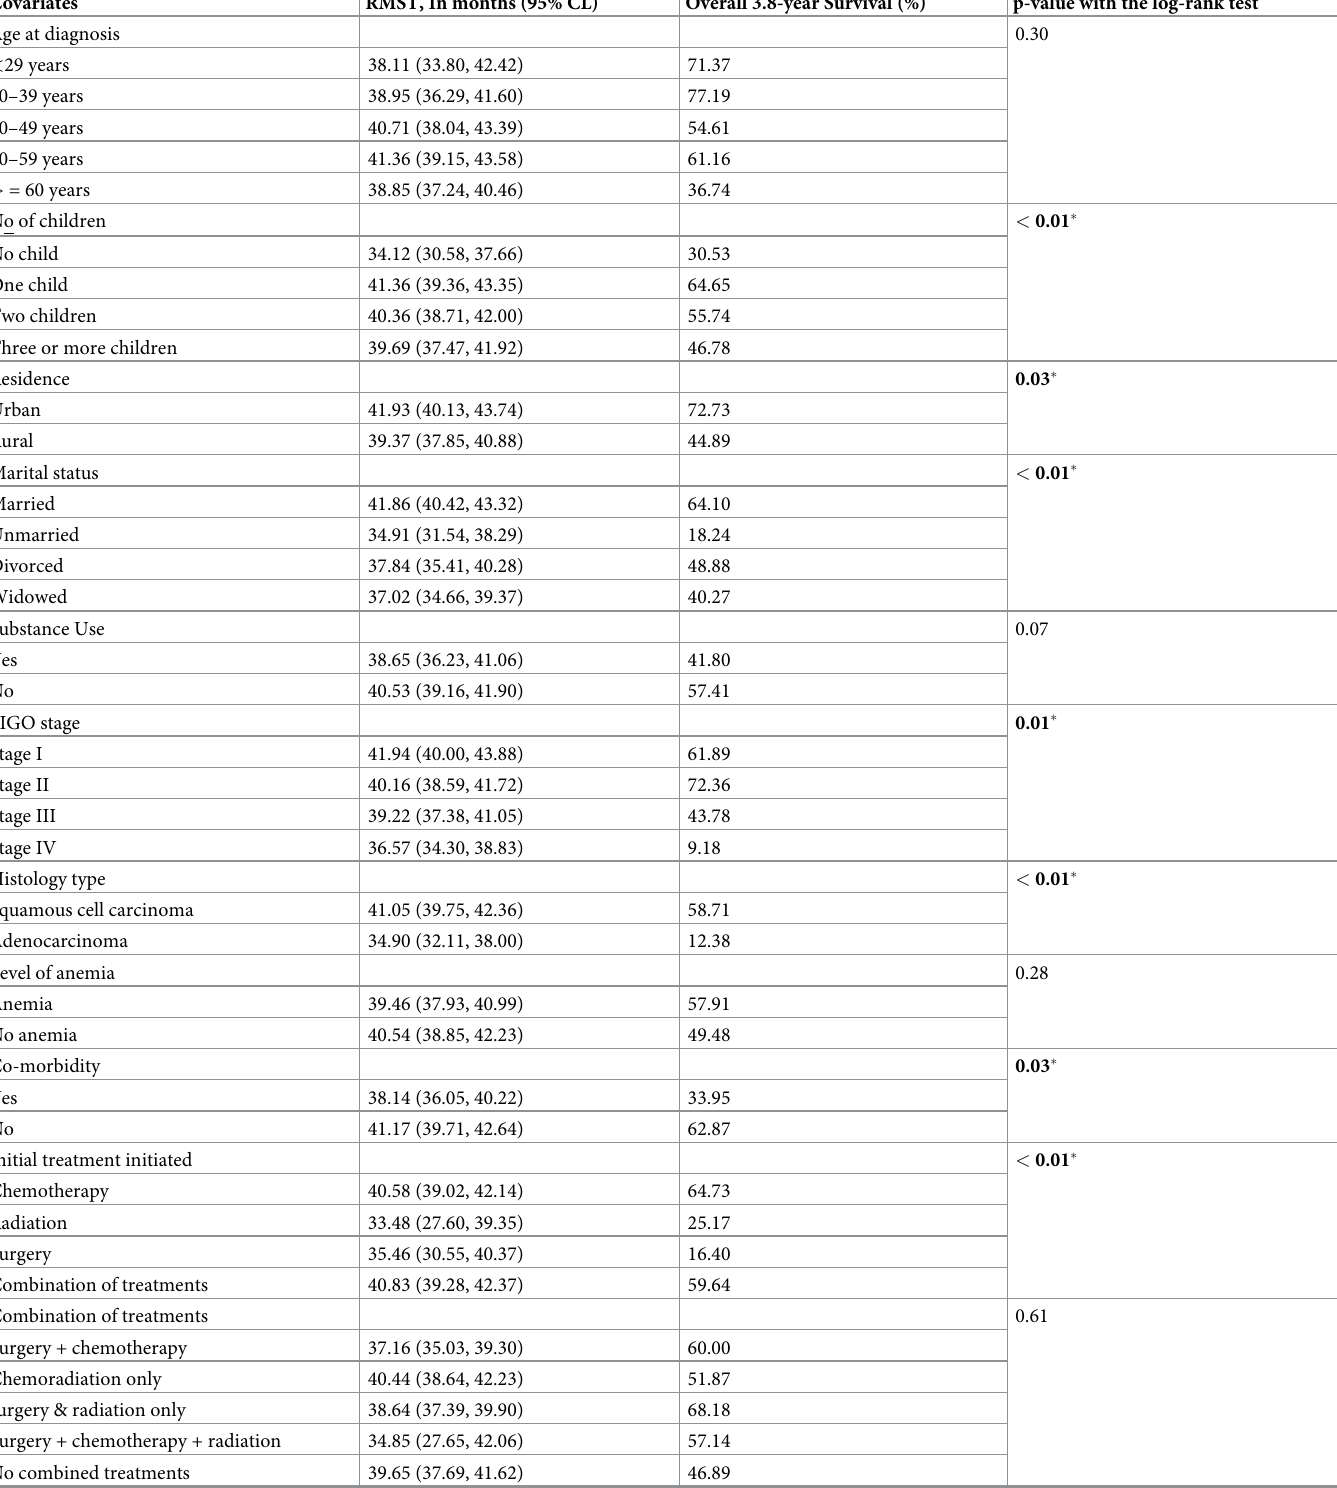
Table 5. Restricted mean survival time, cumulative survival probability, and log rank test of cervical cancer patients at Felege Hiwot Comprehensive Specialized Hospital Oncology Center, Ethiopia (N = 422, March 2021).